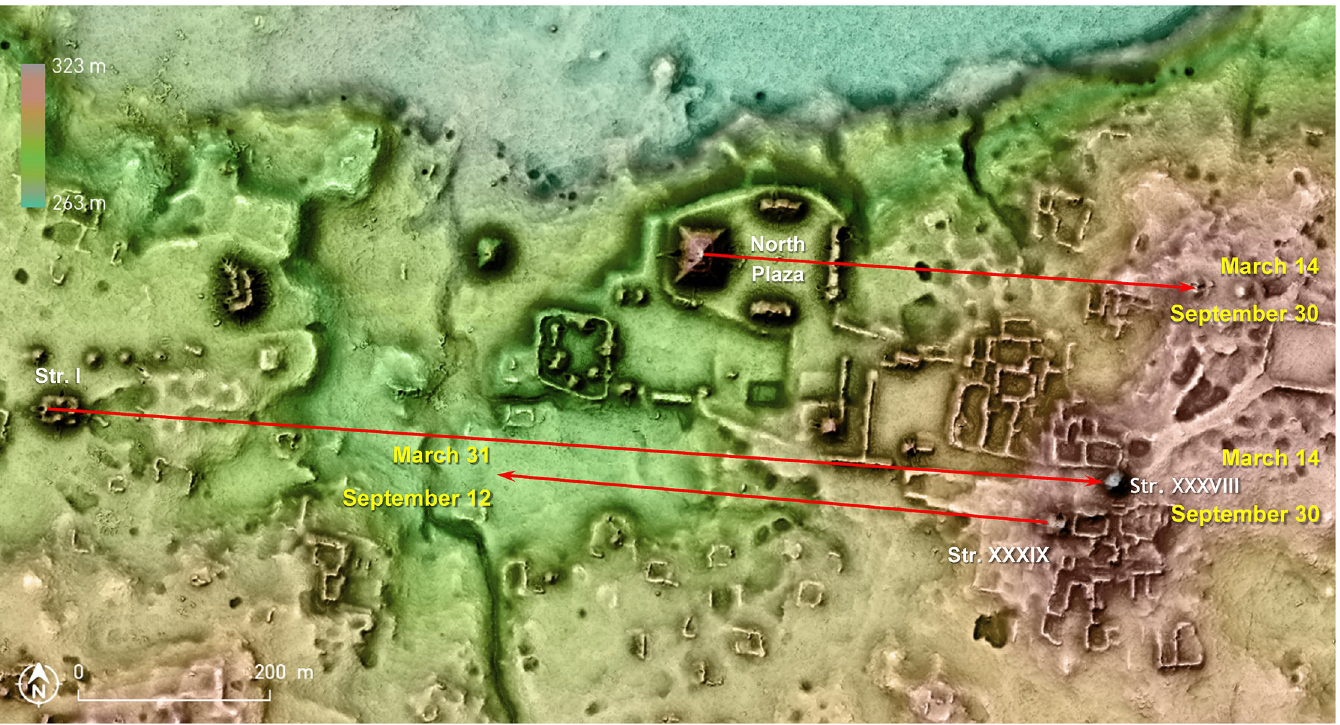
Fig 14. Lidar-derived relief of Naachtu´n (extracted from the Pacunam PLI survey and provided by Philippe Nonde´de´o), with alignments discussed in the text (visualization by Zˇiga Kokalj).